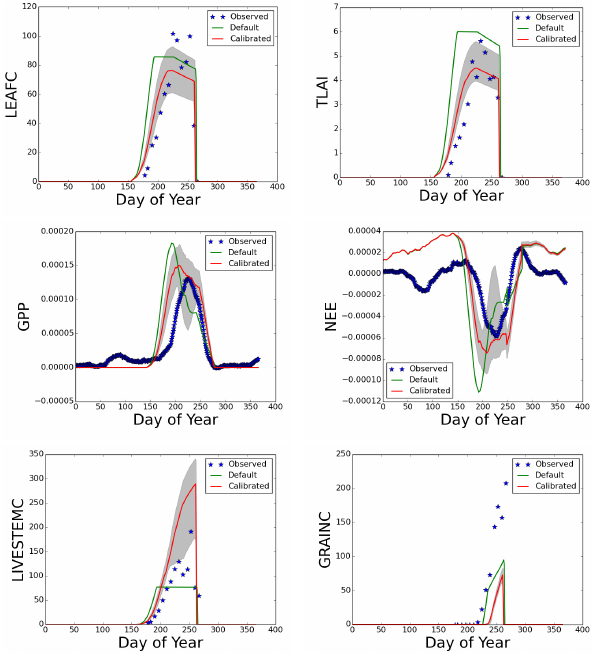
Figure 7. Validation experiment (Bondville, IL): comparison of the observed data for 2004 with the model started in 2002. The grey areas correspond to 95% confidence error bars.